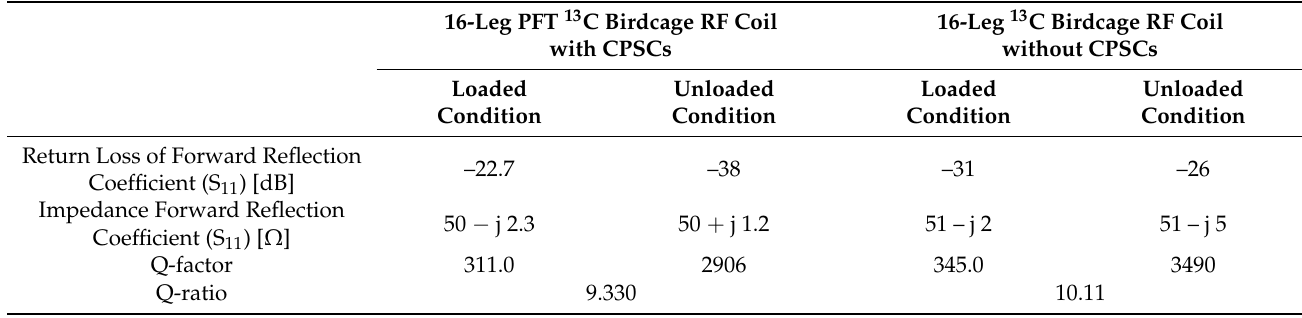
Table 1. Network analyzer measurements of the 16-leg PFT 13 C birdcage RF coil using the vector network analyzer. The forward reflection coefficients are measured in the loaded condition where the swine is placed inside the 16-leg PFT 13 C birdcage RF